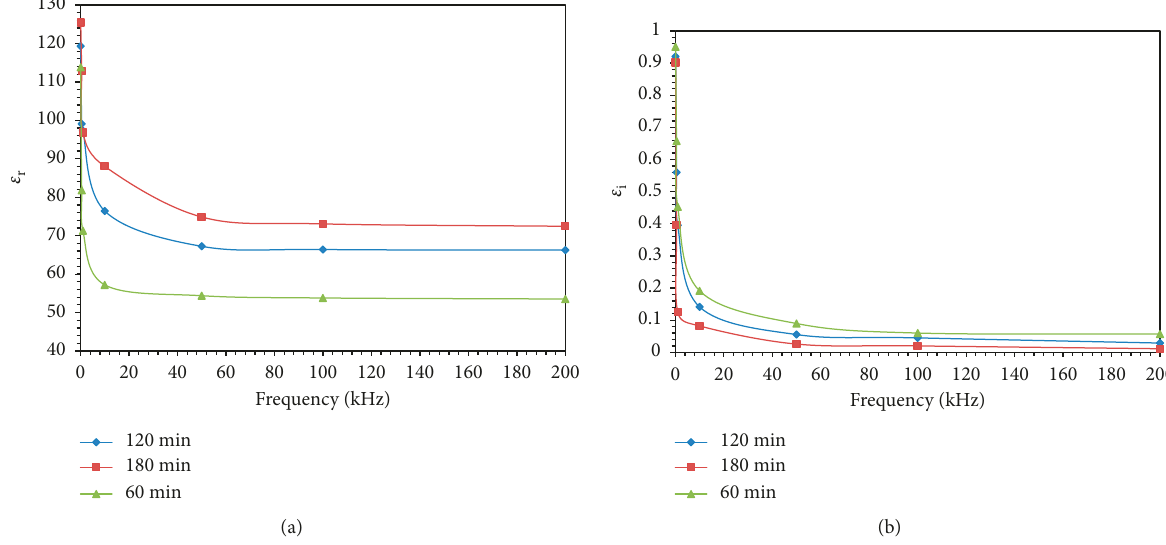
Figure 13: Variation of dielectric constant ε r (a) and dielectric loss ε i (b) as a function of frequency with different holding